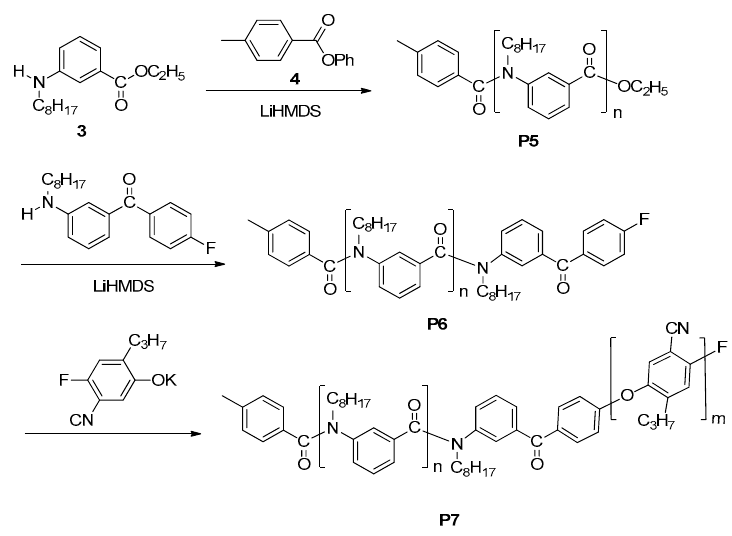
Scheme 2. Block polymers obtained by chain-growth polycondensation.